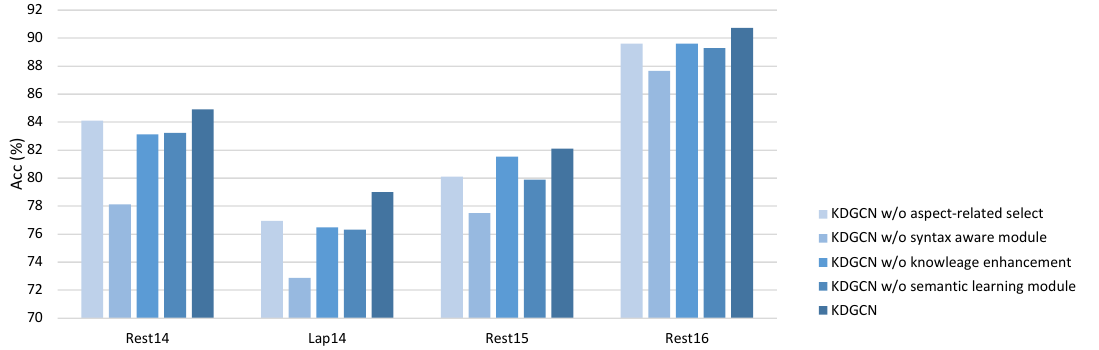
Figure 4. Results of the ablation study. Different columns show the performance of different models on different